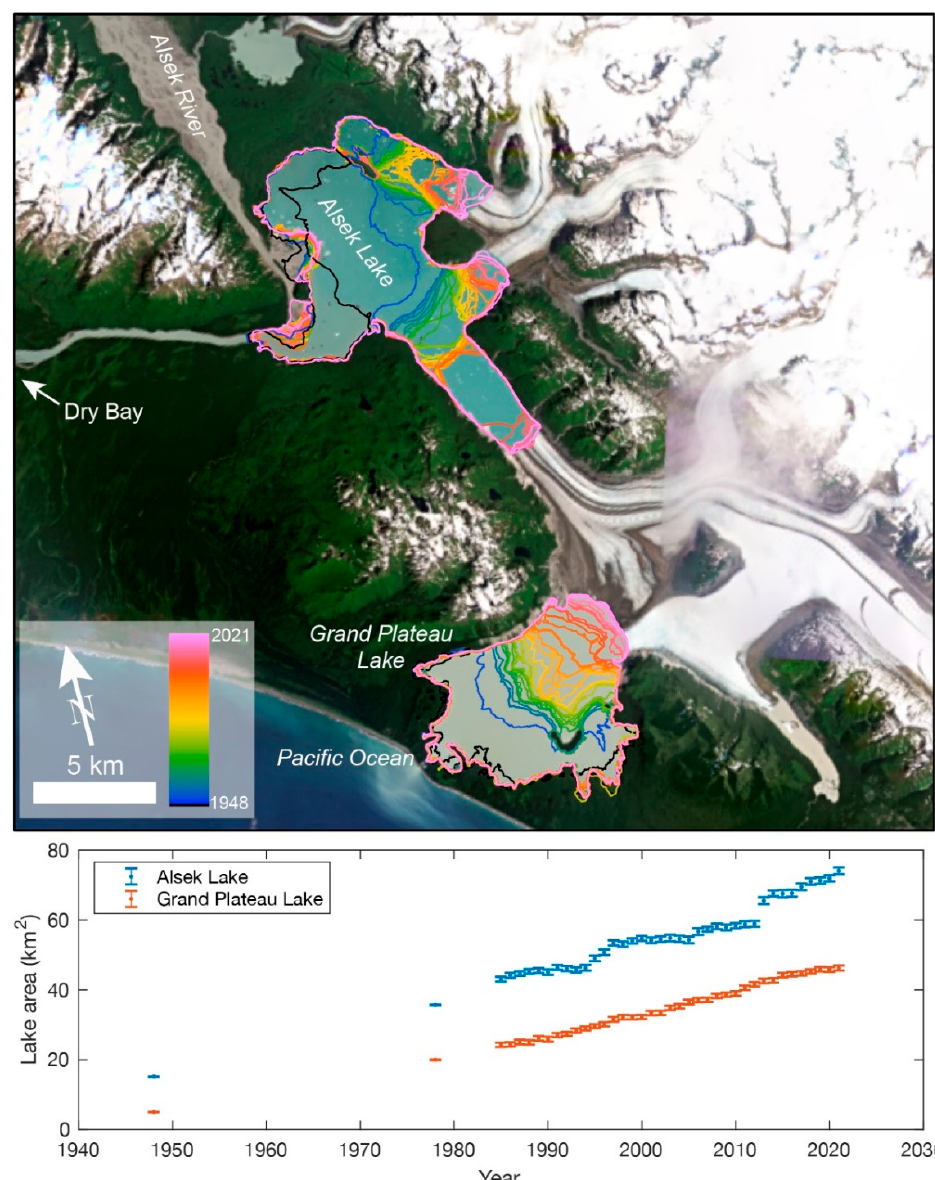
Figure 6. Recent growth of Grand Plateau and Alsek lakes, Alaska. Upper panel shows lake extents annually from 1985 to 2021 (from Landsat imagery), plus 1948 and 1978 (from georeferenced historic air photos). Background image is a July 2021 satellite mosaic from Planet and projection is Alaska Albers Equal Area Conic. Lower panel is time series of the lake areas. Error bars are per [58].